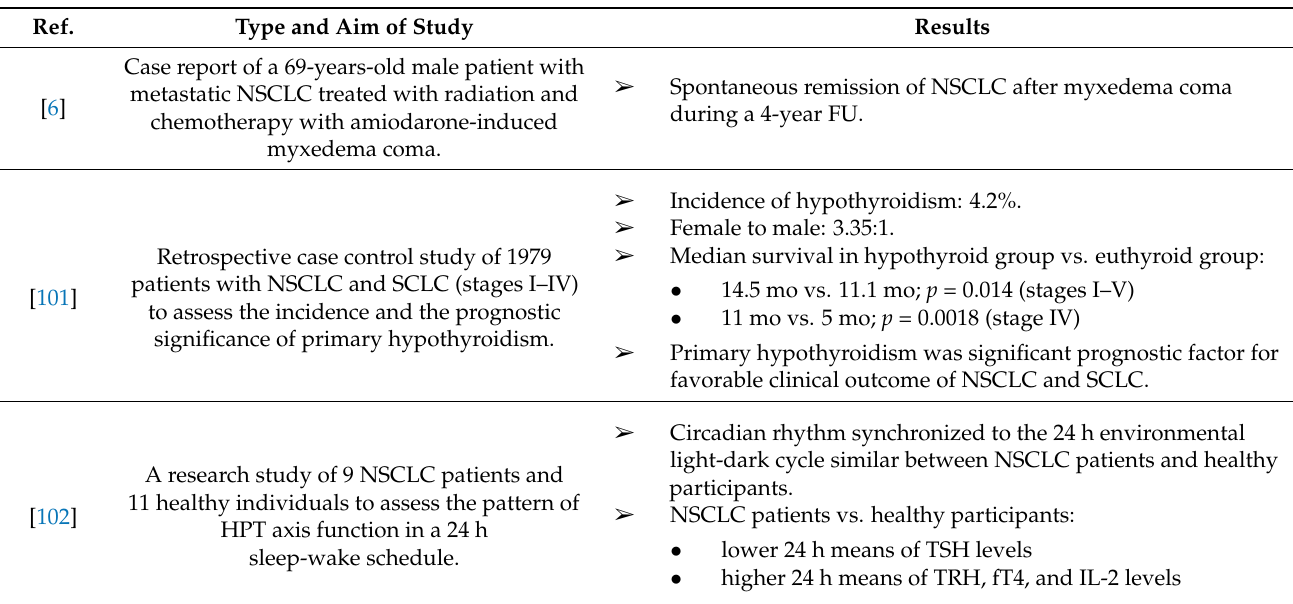
Table 3. Clinical studies addressing the thyroid hormones–lung cancer